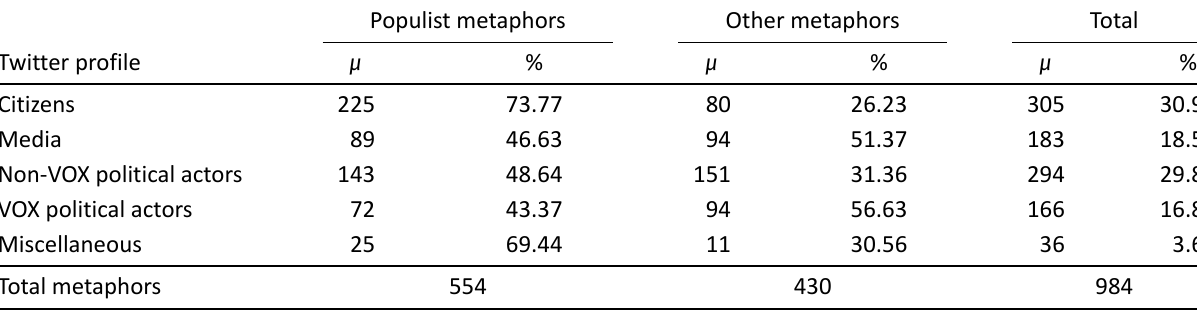
Table 3. Metaphor use by Twitter